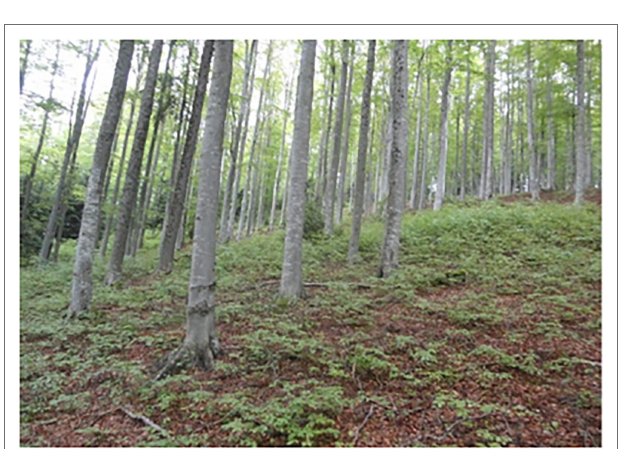
FIGURE 5 | Image for the category of thermophilous deciduous forest . Source : European Red List of Habitats—Forests Habitat Group. Reproduced with permission from Stamatis Zogaris, available at https://acortar.link/